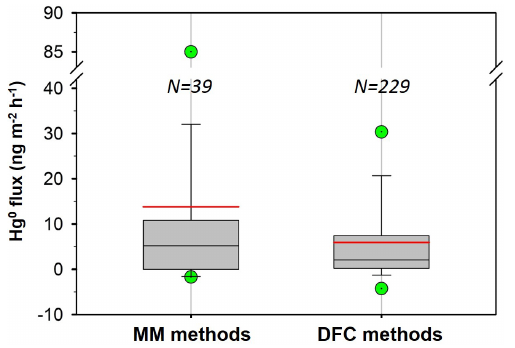
Figure 3. Box and whisker plots of Hg 0 fluxes measured by MM methods and DFC methods. (Flux data including measurements from background soils, agricultural fields, grasslands and wetlands at substrate total Hg lower than 0.3µgHgg − 1 , data source: Table 1. The two box horizontal border lines indicate 25th and 75th per- centiles, whiskers represent 10th and 90th percentiles and outliers (green circles) indicate 5th and 95th percentiles from bottom to top. Red line and black line indicate mean and median